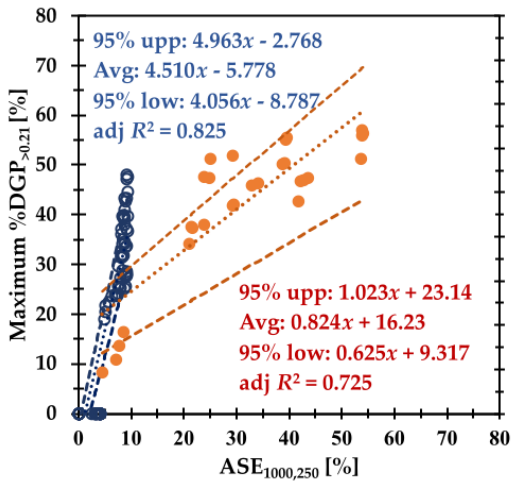
Figure 16. Regression model of the maximum %DGP >0.21 with respect to ASE 1000,250 , based on data from reference [55].